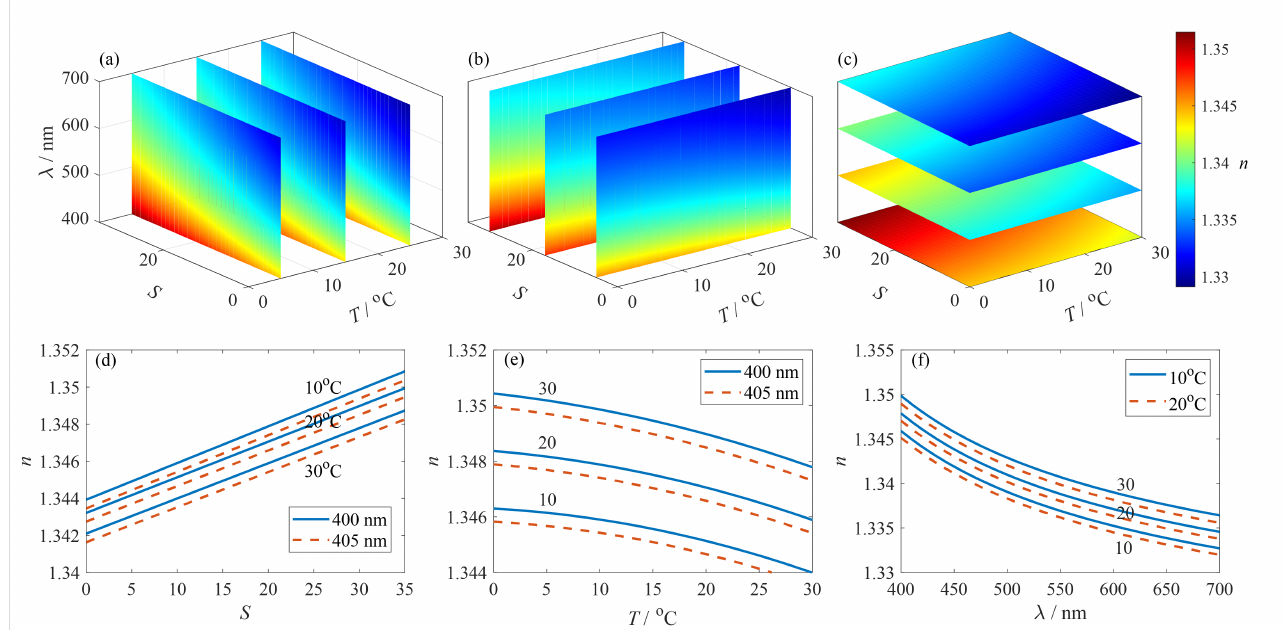
Figure 3. The relation of refractive index and salinity, temperature and wavelength. ( a ) Temperature slice planes. ( b ) Salinity slice planes. ( c ) Wavelength slice planes. ( d ) The refractive index versus salinity under different temperature and wavelength. ( e ) The refractive index versus temperature under different salinity and wavelength. ( f ) The refractive index versus wavelength under different salinity and